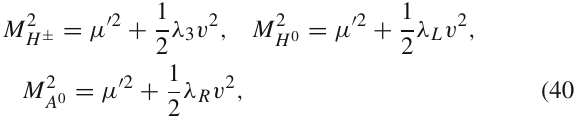
correspondence with the M V ∼ 1 near the threshold of the V V → H 2 H 2 annihilation process (Fig.